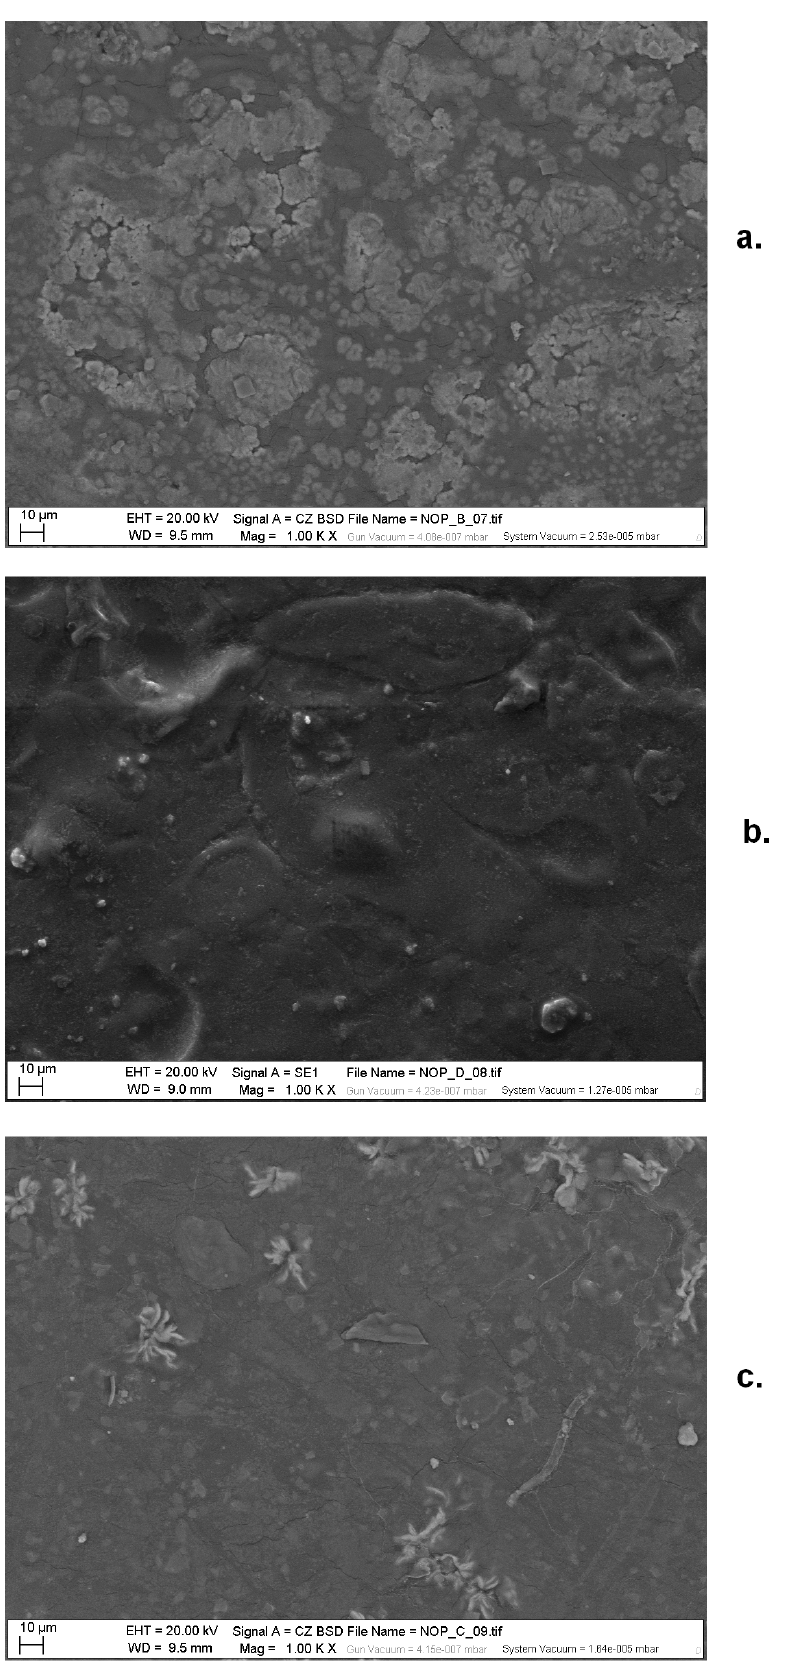
Figure 12. SEM images of blended films TPS–nopal mucilage (type MA (a.), ME (b.). and MPM (c.)). Magnification 1000×.